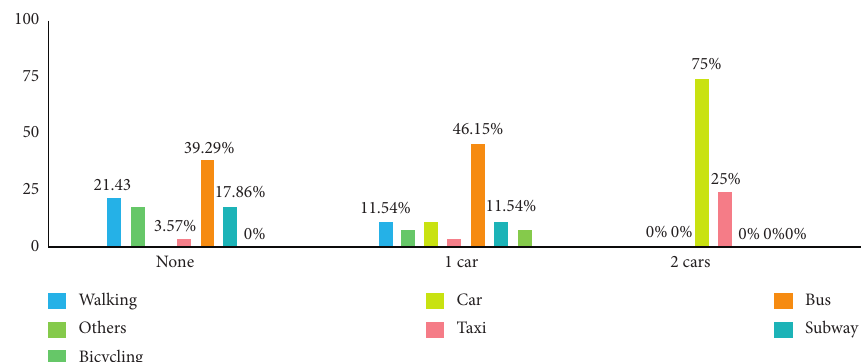
Figure 4: Cross distribution diagram of car ownership and travel mode selection of respondents’ family. Table 1: Test results of the KMO and Bartlett test. The sampling fitness of